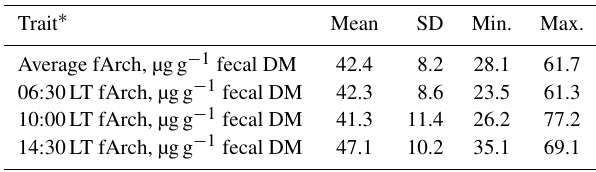
Table 1. Descriptive statistics for the fecal archaeol